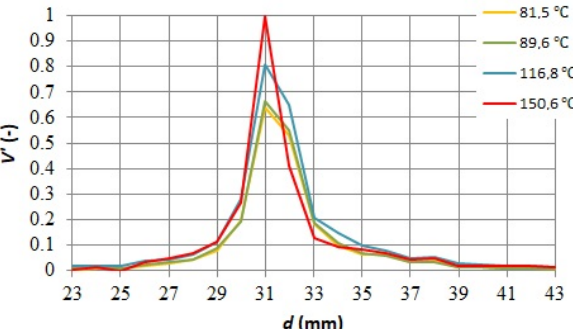
Figure 9. Relationship between EOG normalized values and the distance d for di ff erent temperature values ϑ p of the observed element.